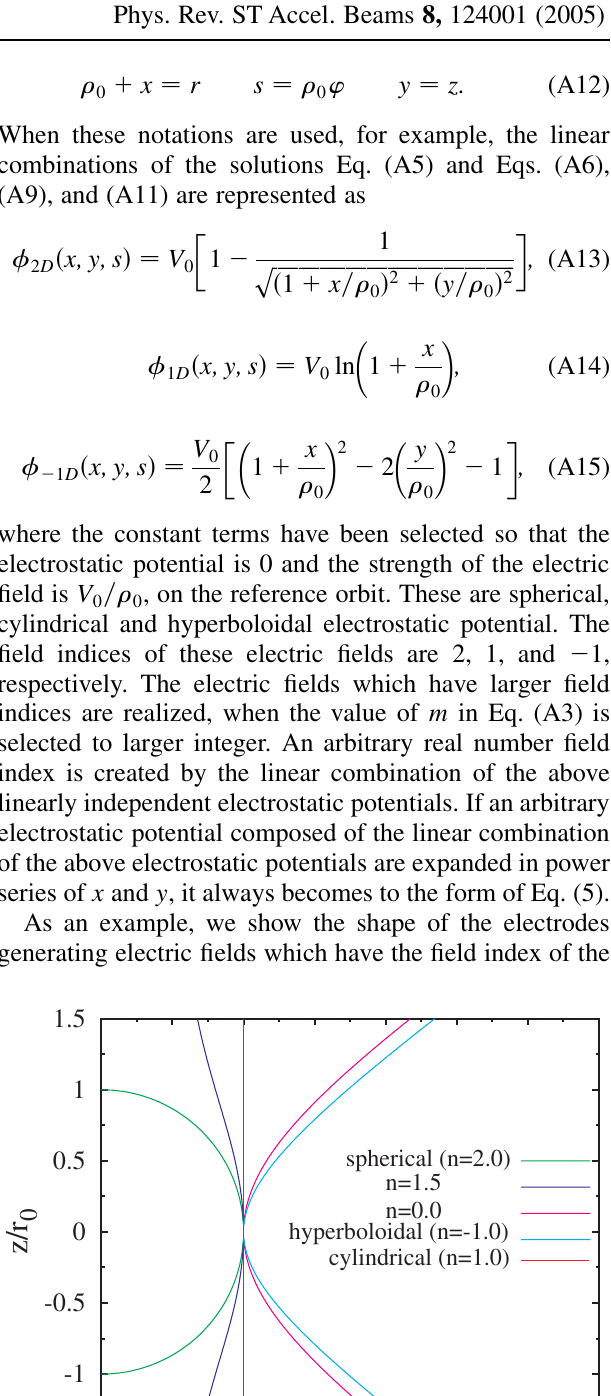
on the hori- 0 (cid:5) (cid:3) ; z=r 0 0